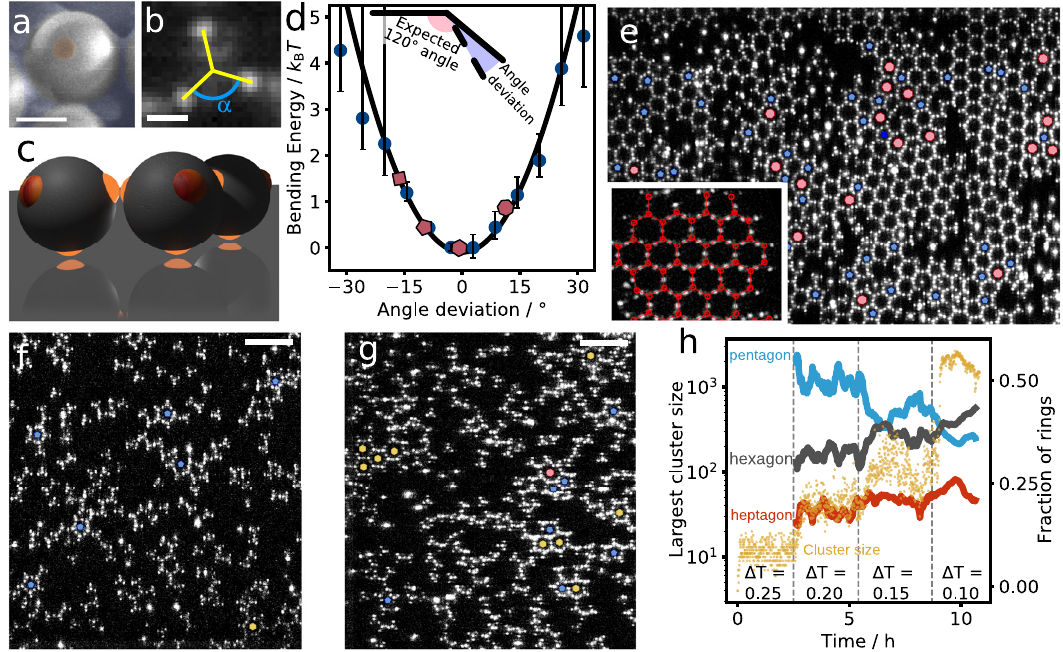
Fig.1|Colloidalgraphene fl akesformedfromtrivalentlycoordinatedparticles. particles(fromlefttoright). e Confocalmicroscopeimageofhoneycomblatticeof a Scanning electron microscopy (SEM) image of patchy particle, with patch high- thepseudo-trivalentparticlesat Δ T =0.05 ∘ Cafter24hofequilibration.Blueandred symbols indicate pentagon and heptagon defects. Inset: enlarged section with lightedinorange. b Confocalmicroscopeimageofpatchyparticle,highlightingthe fl uorescently labelled patches (bright spots). The projected angle between the particle centres highlighted in red, showing the honeycomb lattice built out of 6-membered rings. f , g Confocal microscope images of the pseudo-trivalent par- patches is α =120 ∘ . Scale bars in ( a ) and ( b ) indicate 1 μ m. c Reconstruction of the surface-bound tetramer patchy particles. One patch is attached to the surface, the ticles at Δ T =0.20°C ( f ) and Δ T =0.15°C ( g ). With increasing attractive strength, remaining three patches available for bonding, making them effectively trivalent. particlesassembleintosmallclusterspreferentiallycontainingpentagons( f ),which Thebondsaretiltedslightlyoutofplane,hencedeviatingslightlyfromtheidealin- grow into larger structures, favouring hexagons (shown in yellow) ( g ). Scale bars plane sp 2 -like bonding. d Bending potential determined from angle fl uctuations of indicate 10 μ m. h Fraction of pentagons (blue), hexagons (black), and heptagons threebondedparticles(bluedots,seeSupplementaryNote6fordetails).Errorbars (red), and largest cluster size (yellow scatter) as a function of time. Dashed lines indicate standard deviation. The black solid line indicates the harmonic fi t delineate temperature changes. Hexagons grow at the expense of the pentagons. k θ 2 withforceconstant k k T /( ∘ ) 2 .Thered n -gonsshowthe U 1 Source data are provided as a Source Data fi le.Source bend =0.012 B bend = bend 2 resulting average bending energy per particle in rings composed of 4, 5, 6, and 7